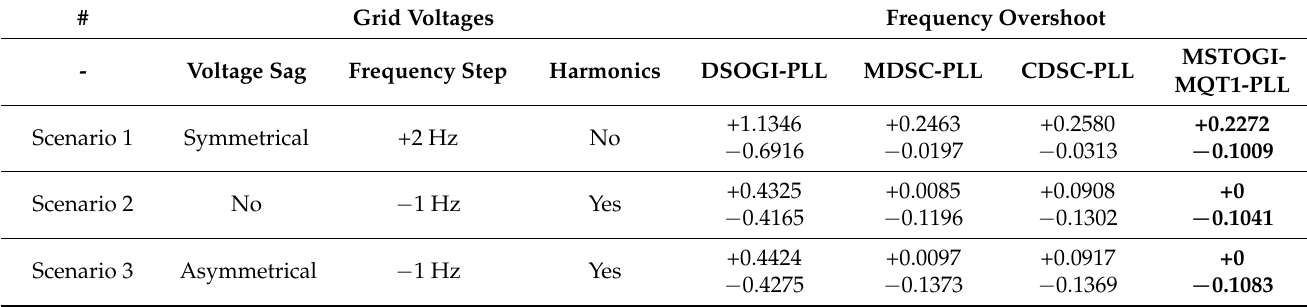
Table 2. Summary of